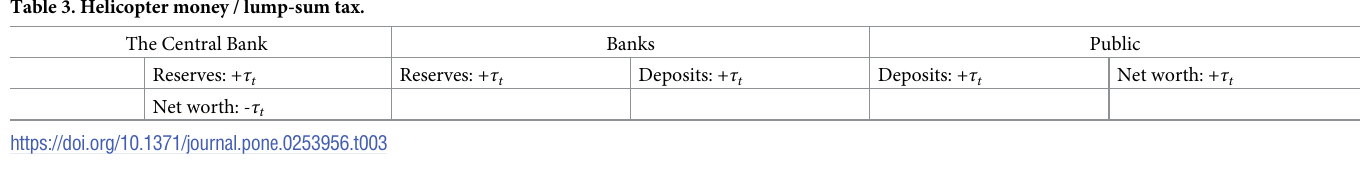
two sub-transactions: one between central bank-bankers is settled by reserves, one between bankers—households is settled by ZMDs (Table 3).